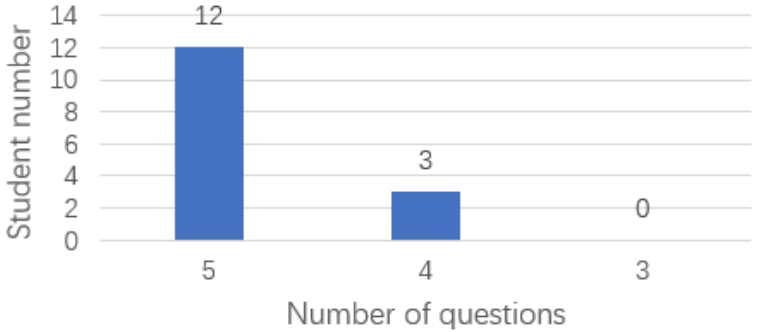
Figure 18. Students answering questions.